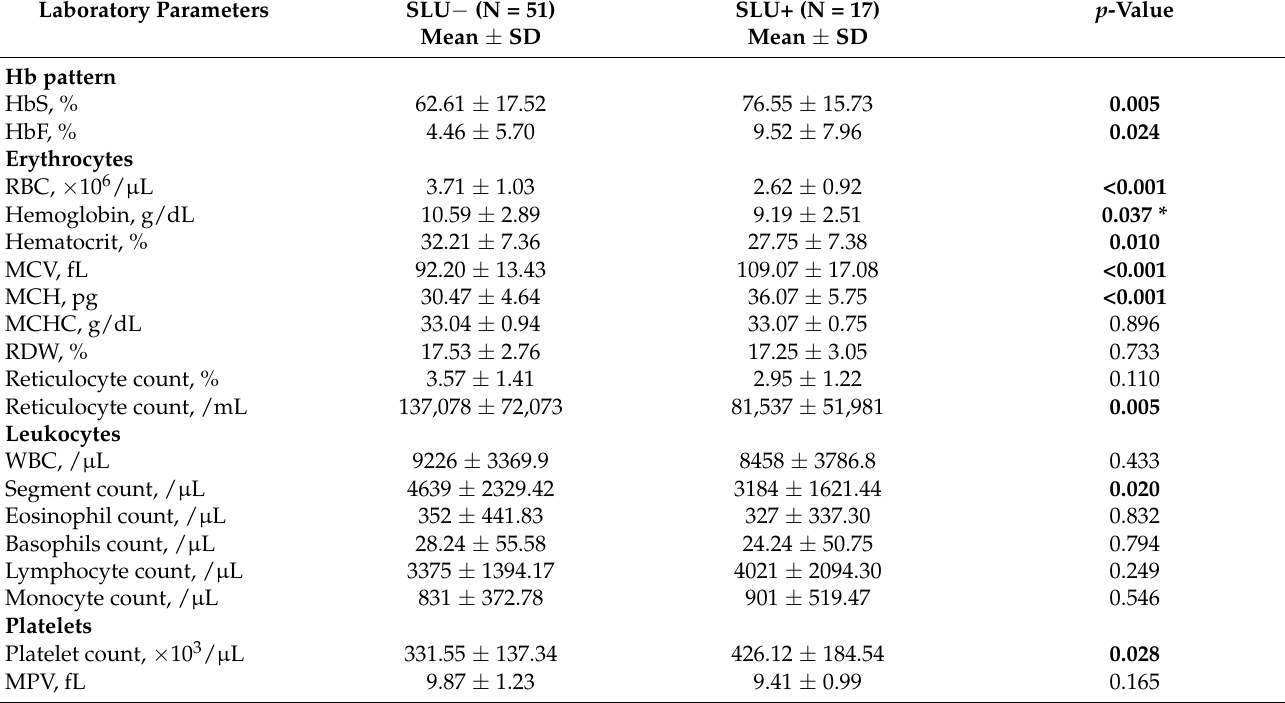
Table 2. Hematological characterization of SLU − and SLU+